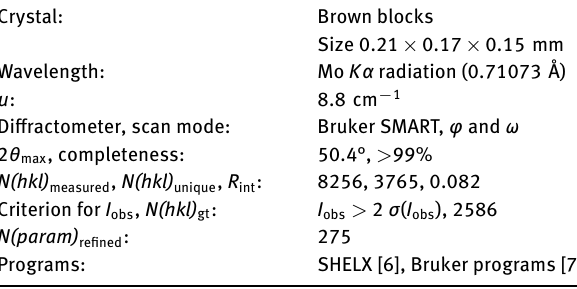
Table 1: Data collection and handling. Crystal: